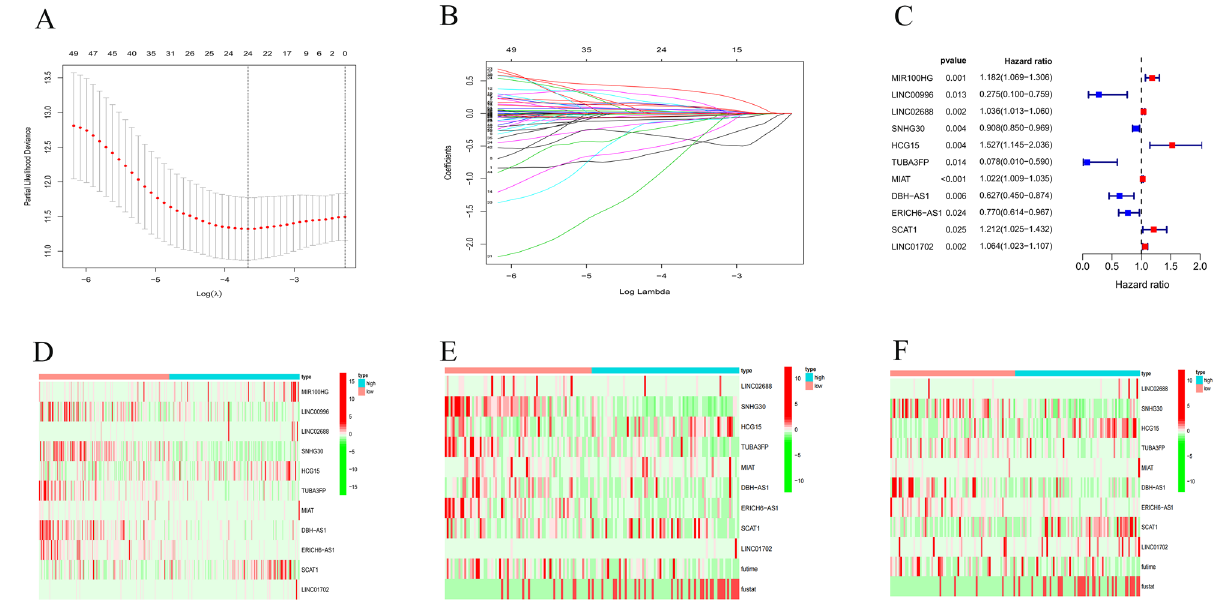
Figure 1. Identification of prognostic necroptosis-related lncRNAs in CESC patients. ( A , B ) Lasso Cox regression analysis showed that 24 of the 56 necroptosis-related lncRNAs were good candidates for construction prognostic model. ( C – F ) Forest plots and a heatmap (green: low expression level, red: high expression level) with two sets of validation datasets of the 11 necroptosis-related